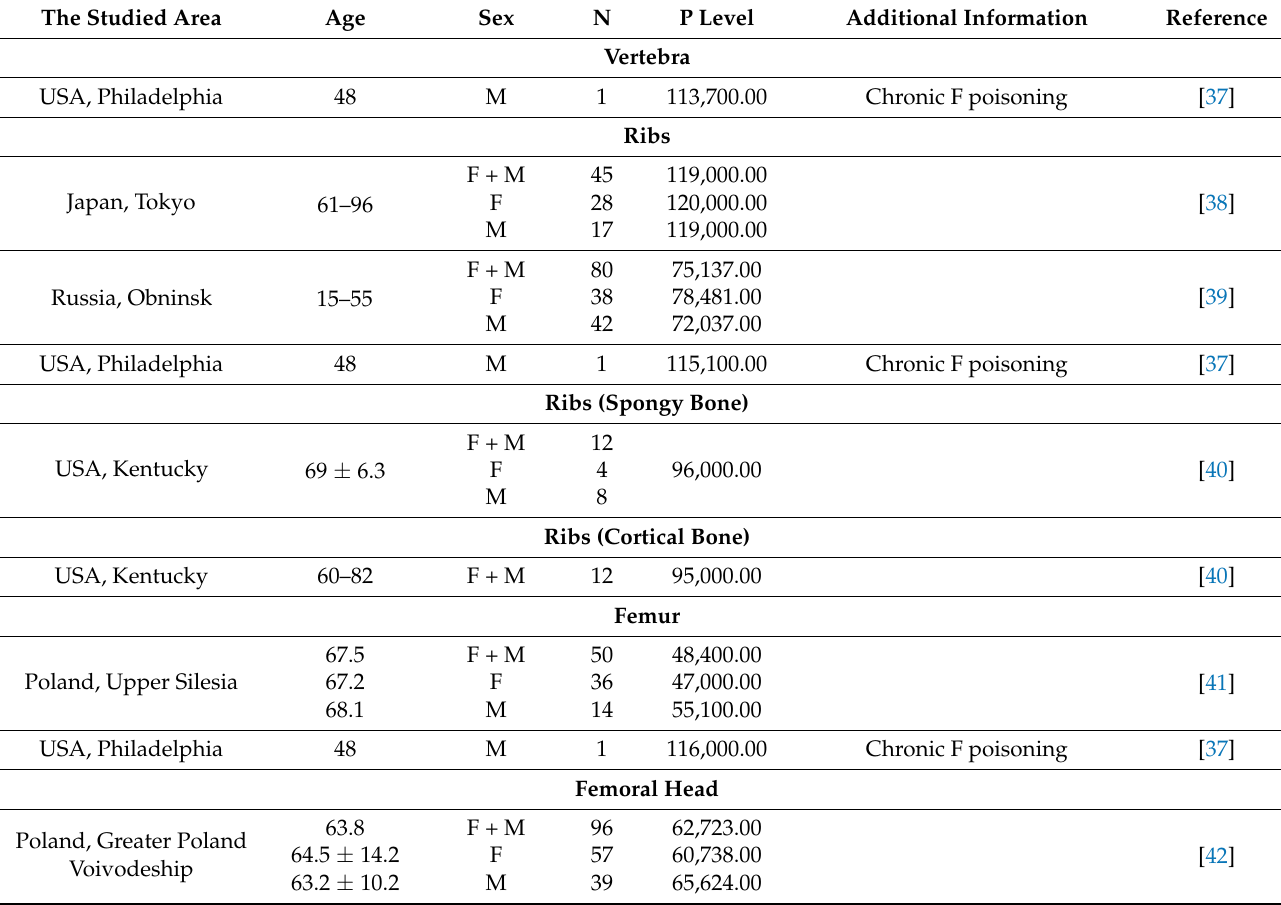
Table 3. Phosphorus levels in human bones in mg kg − 1 dw. (F, female; M, male; N, number of participants; NS, nonsmoking; S,